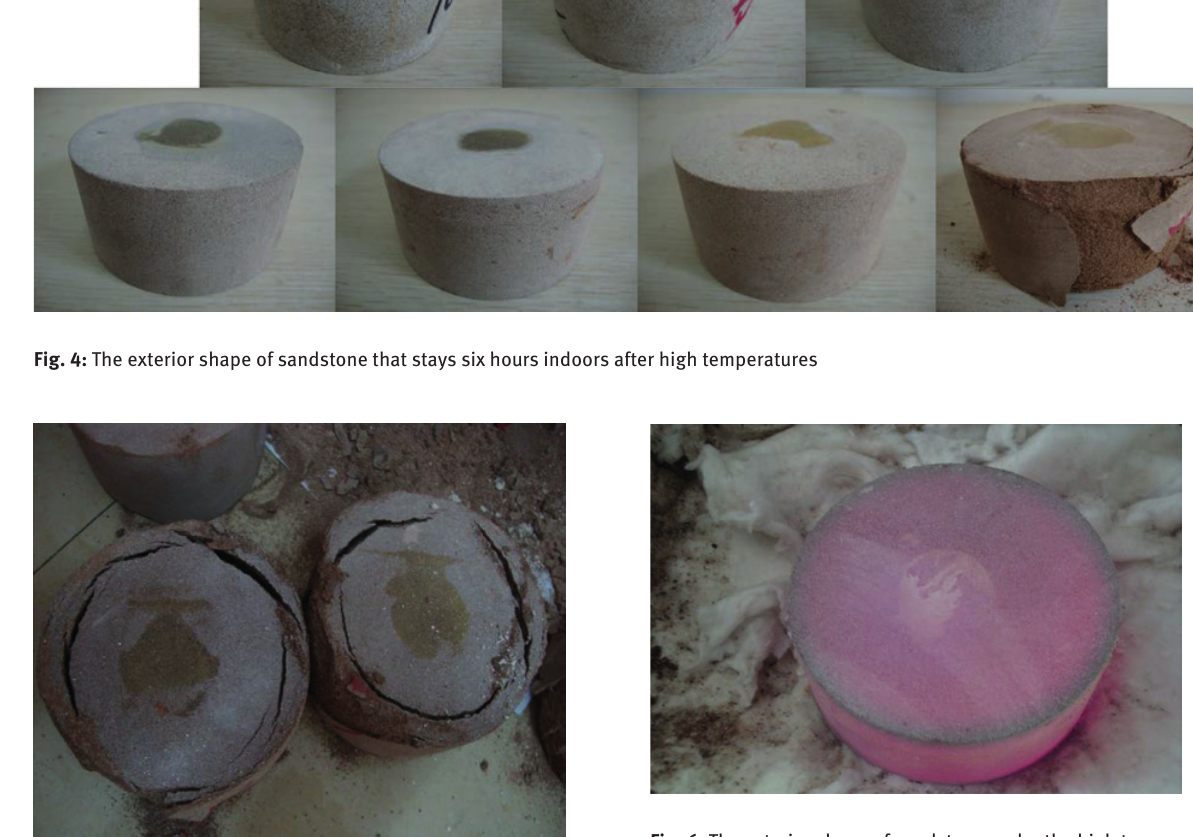
Fig. 6: The exterior shape of sandstone under the high temperature of 1000